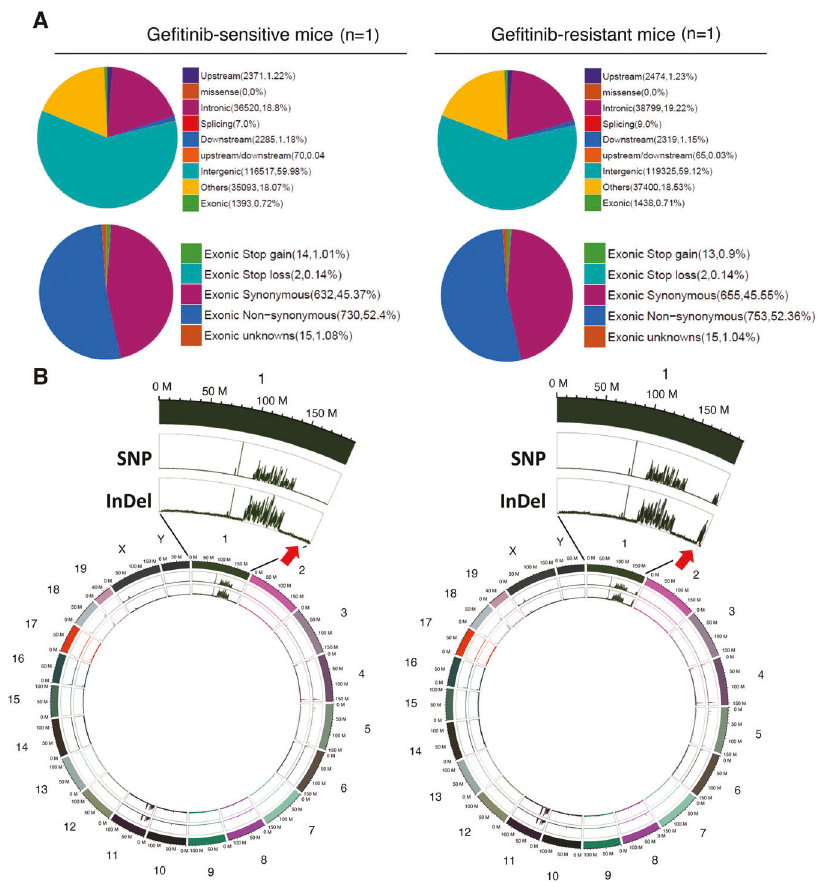
Fig. 3 Ge fi tinib-induced drug resistance induces genomic instability in EGFR L858R -induced lung cancer mice. The percentages of sequence mutations in the various regions of the whole-genome sequence (WGS), Ge fi tinib-sensitive mice ( n = 1) and Ge fi tinib-resistant mice ( n = 1) are shown here ( A ). The single nucleotide polymorphism (SNP) and small insertions/deletions (InDel) pro fi les and the highlighted region on Chromosome 1 are shown on a Circus plot. The red arrow indicates the change during drug resistance acquisition in mice with lung cancer ( B